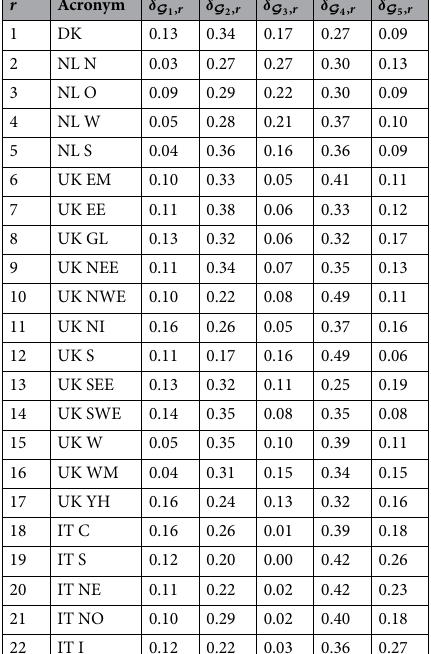
Table 2. Distribution of the Symbolic Universes in each of the sampled 22 regional populations. The reported values are approximated to the second decimal place, and hence some rows may not exactly sum up to 1.